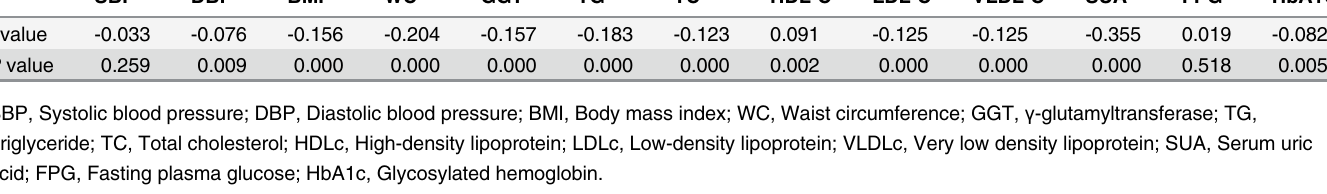
without NAFLD in phase one, two and three (All P < 0.05). However, there was no significant (Both P > 0.05).